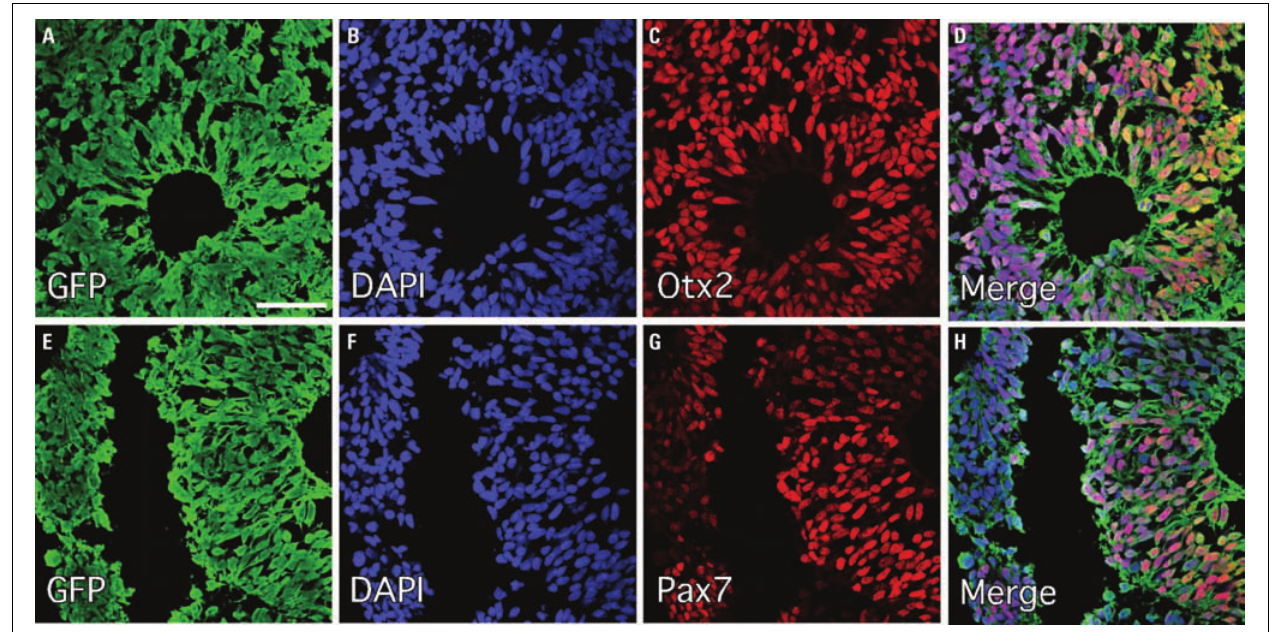
FIGURE 2 | Up-regulation of intrinsic markers of dorsal and forebrain identity following neural induction of human ES cells under minimalist conditions. Immunohistochemistry for transcriptional markers of regional identity following PA6 neural induction (10 days) and neurosphere differentiation (7 days) showed robust expression of the telencephalic marker